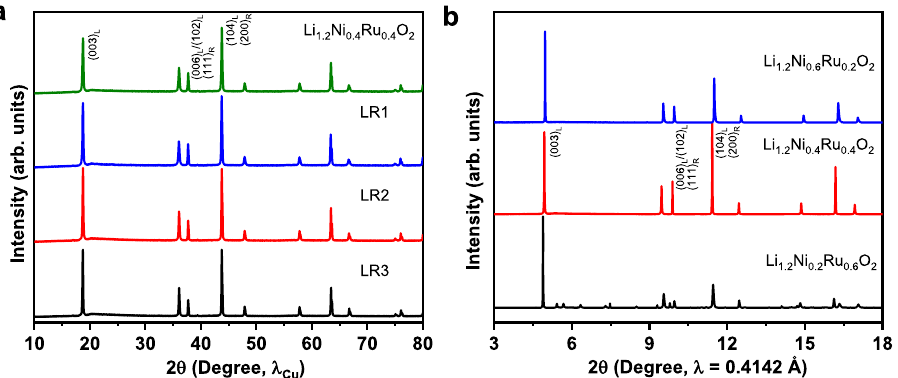
Fig. 6 New Li-rich metal oxides of different Ni/Ru combination. a XRD patterns based on Ni 2 + /Ru 5 + combination, showing layered-rocksalt intergrown structure. The designed layered-rocksalt samples Li 7/6 Ni 4/9 Ru 7/18 O 2 , Li 5/4 Ni 1/3 Ru 5/12 O 2 , and Li 4/3 Ni 2/9 Ru 4/9 O 2 are labeled as LR1, LR2, and LR3, respectively. b XRD patterns based on varied oxidation states of Ni/Ru, where Ni 2 + /Ru 4 + in Li 1.2 Ni 0.2 Ru 0.6 O 2 and Ni 3 + /Ru 5 + in Li 1.2 Ni 0.6 Ru 0.2 O 2 lead to layered structure vs. layered-rocksalt intergrown structure for Ni 2 + /Ru 5 + in Li 1.2 Ni 0.4 Ru 0.4 O 2 . Critical re fl ections are indexed as (hkl) L and (hkl) R for R (cid:1) 3 m and Fm (cid:1) 3 m ,